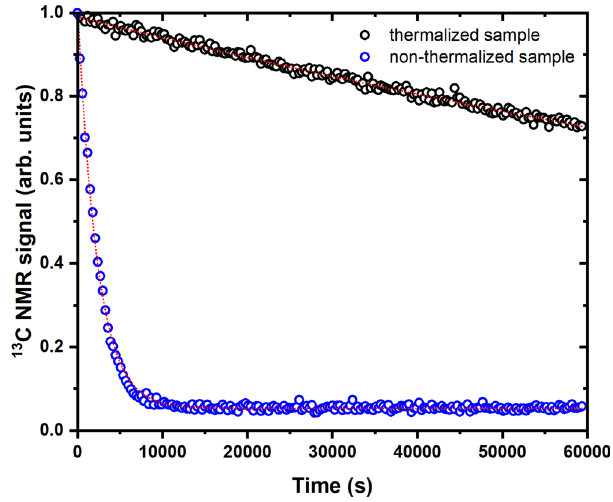
Fig. 3 Extended spin-lattice relaxation for a sample after quenching of the radicals at 6.7 T and 4.2 K. 13 C T 1 measurements for a thermalized (black circles) and non-thermalized sample (blue circles). Each experimental data point was acquired every 10 min. Red dotted curves are the result of a mono-exponential fi t to the data. The T 1 values for the non- thermalized and thermalize sample were 2300 ± 20 s and 200,000 ± 3600 s, respectively ( R 2 =